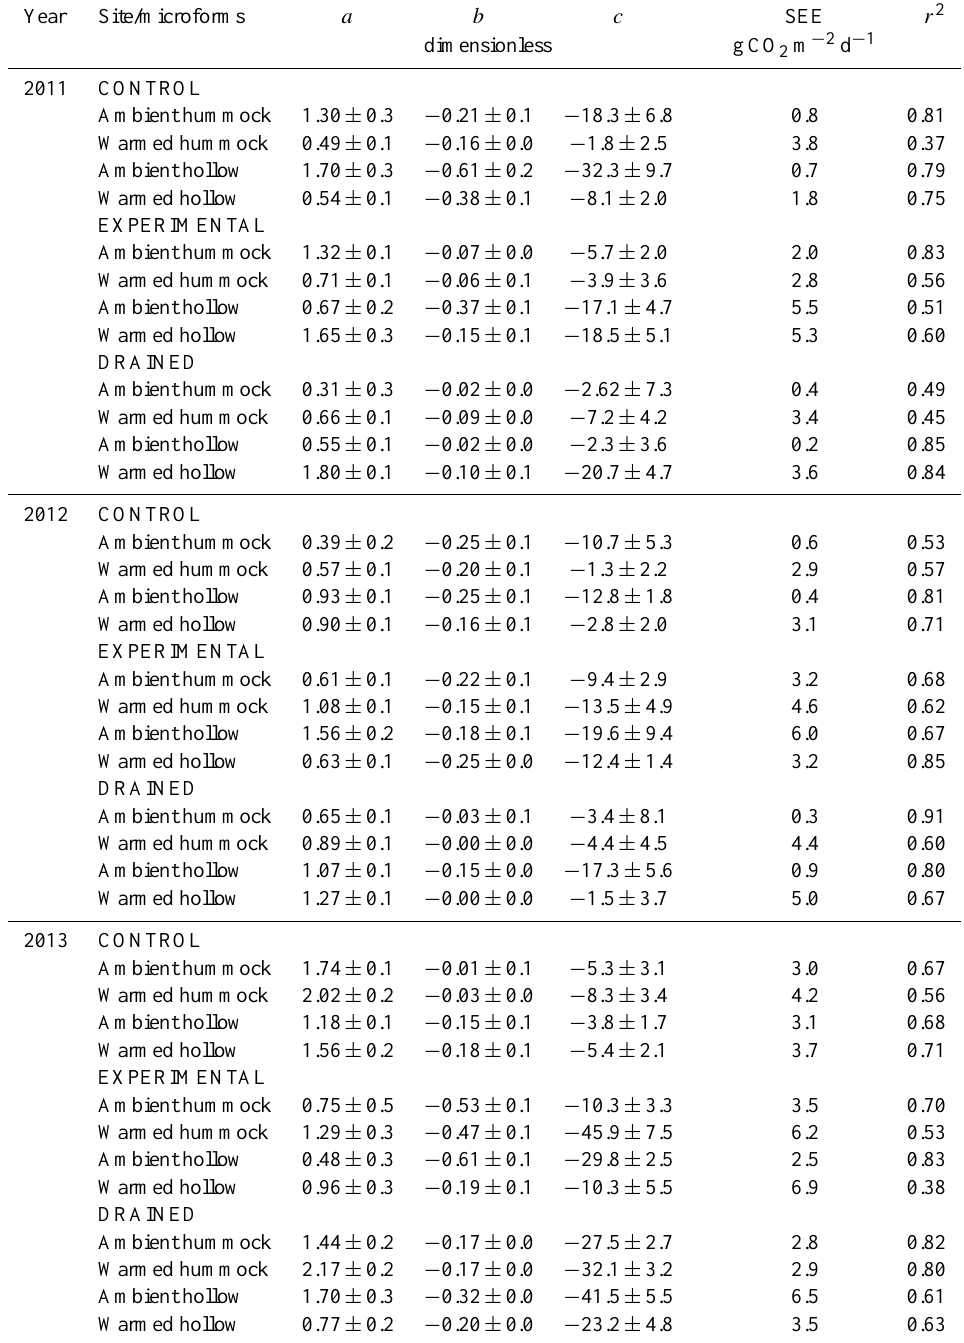
Table A2. Estimated regression coefficient values ( ± SE), standard error of the estimate (SEE) and goodness of fit ( r 2 ) for the forest floor respiration ( R ff ) model (Eq. 2) ∗